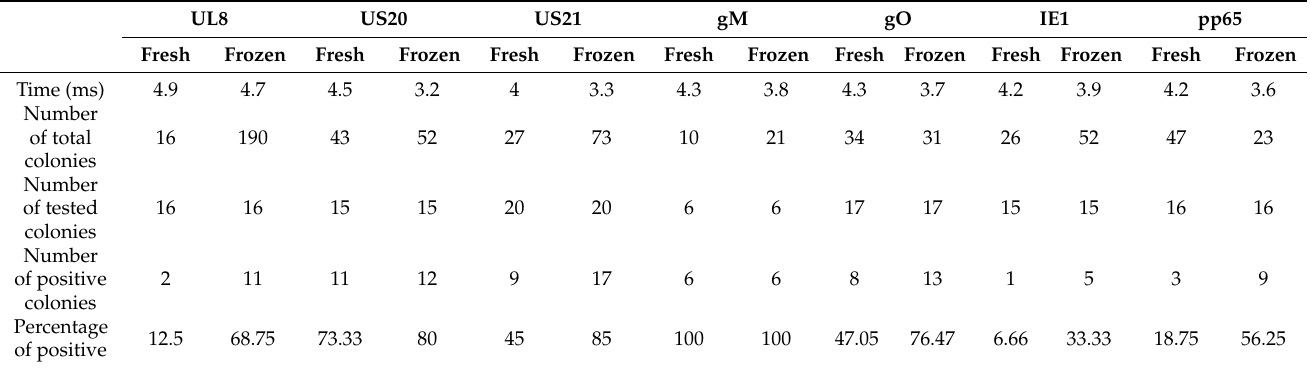
Table 3. Comparison of the results using freshly prepared (Fresh) versus frozen electrocompetent cells for each of the indicated genes. The electroporation was performed at 1.8 volts, and the time constant (Time) and the number of colonies obtained for each transformation are